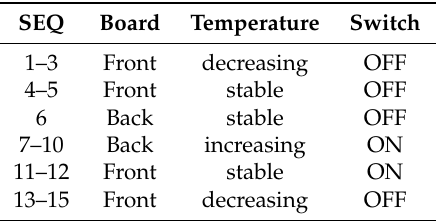
Table 1. Different conditions to observe thermal profile of PCB and associated components.